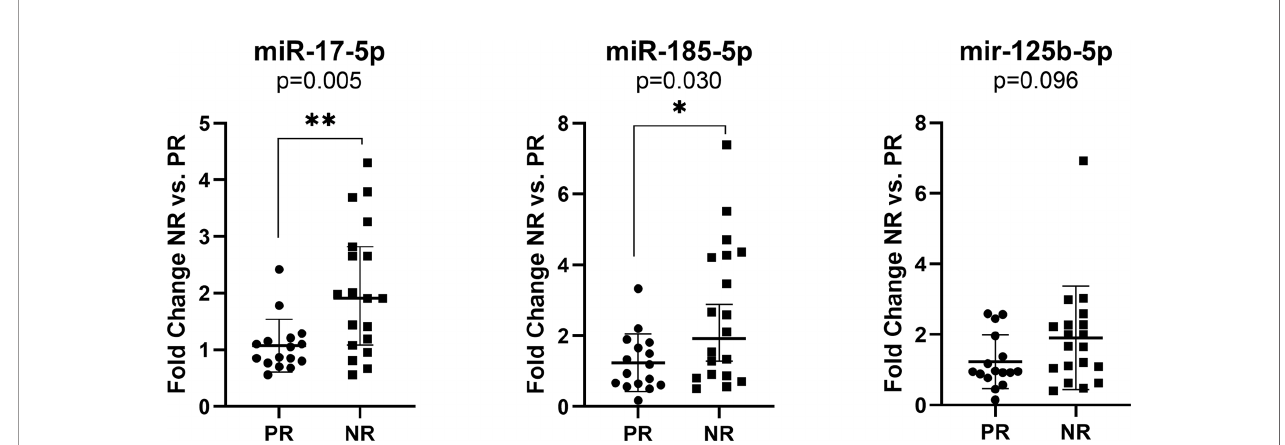
FIGURE 3 | Expression of miR-17-5p, miR-185-5p, and miR-125b-5p in the plasma exosomes of non-responders versus responder (n=19/16) colorectal cancer patients regardless of the treatment received. According to data distribution, differential expression was tested using the non-parametric Mann-Whitney U test. Fold change for each sample was calculated relative to PR group. *p ≤ 0.05; **p ≤